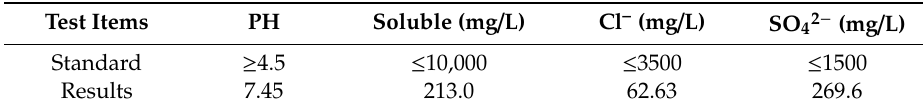
Table 5. Tap water indexes.